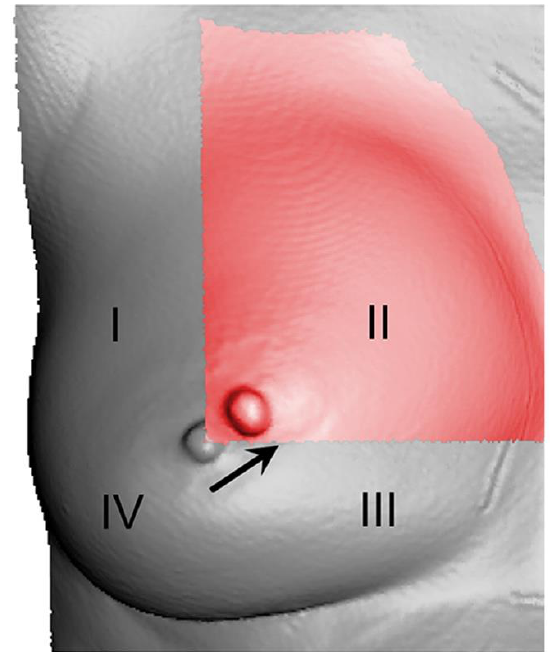
Figure 7. Nipple position change. I = superolateral, II = superomedial, III = inferomedial and IV = inferolateral breast quadrant. This is an example on how the nipple moves into quadrant II after augmentation in a 3D scan. Native scan = grey, scan of the augmented breast with anatomical implant of size 320 cc = red. Table 5. Nipple position shift. Q1 = superolateral quadrant, Q2 = superomedial quadrant, Q3 = infer- omedial quadrant. Anatomical, No. Total Q1